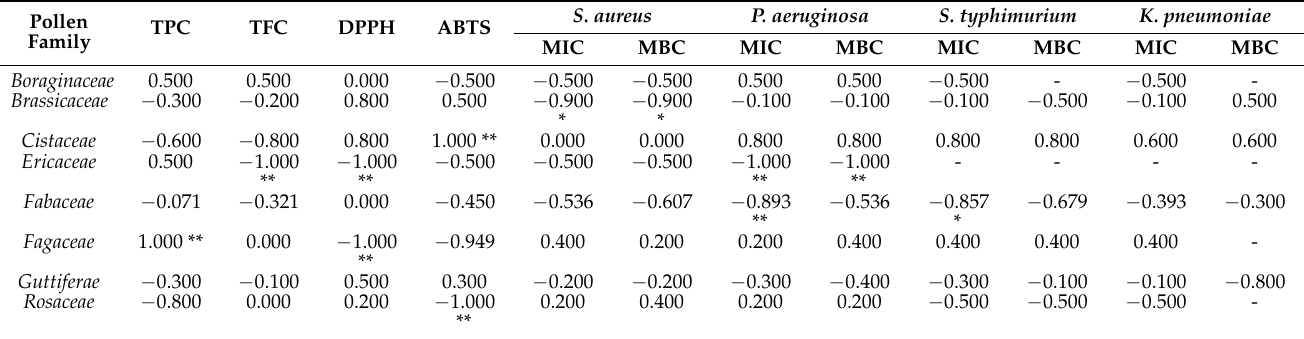
Table 5. Correlation coefficient (r) values estimated from correlation analysis of TPC, TFC, antioxidant activity, and antimicrobial activity values against dominant families of pollen content in each sample.